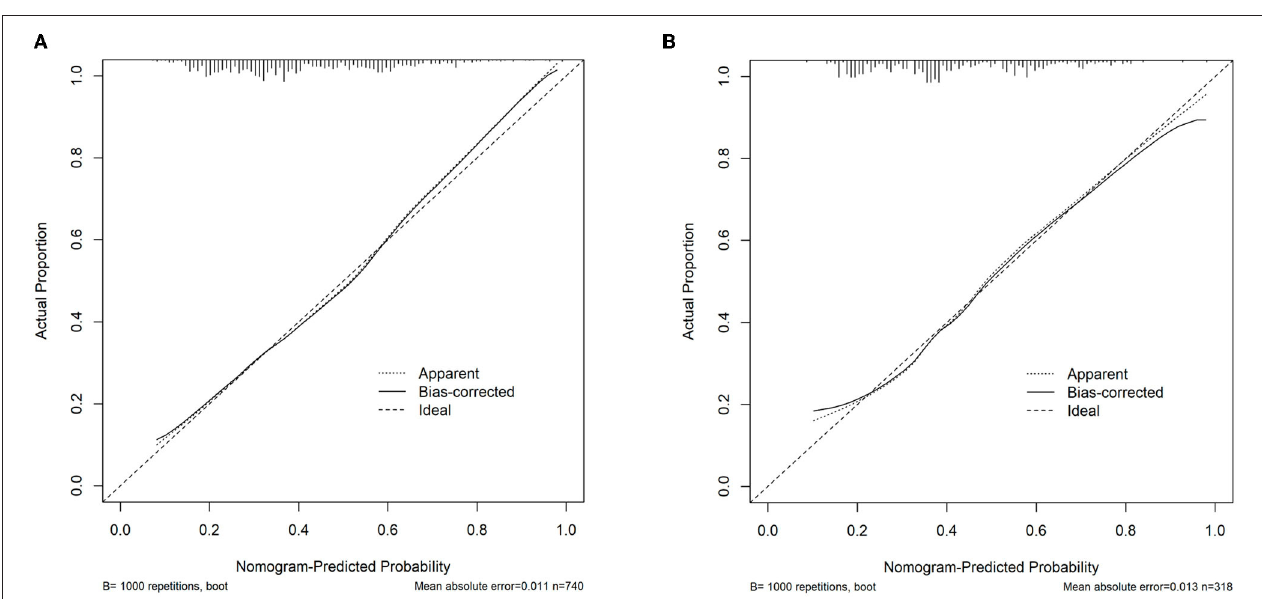
FIGURE 4 | Assessment of the nomogram model calibration. (A) Calibration curve in the training cohort. (B) Calibration curve in the validation